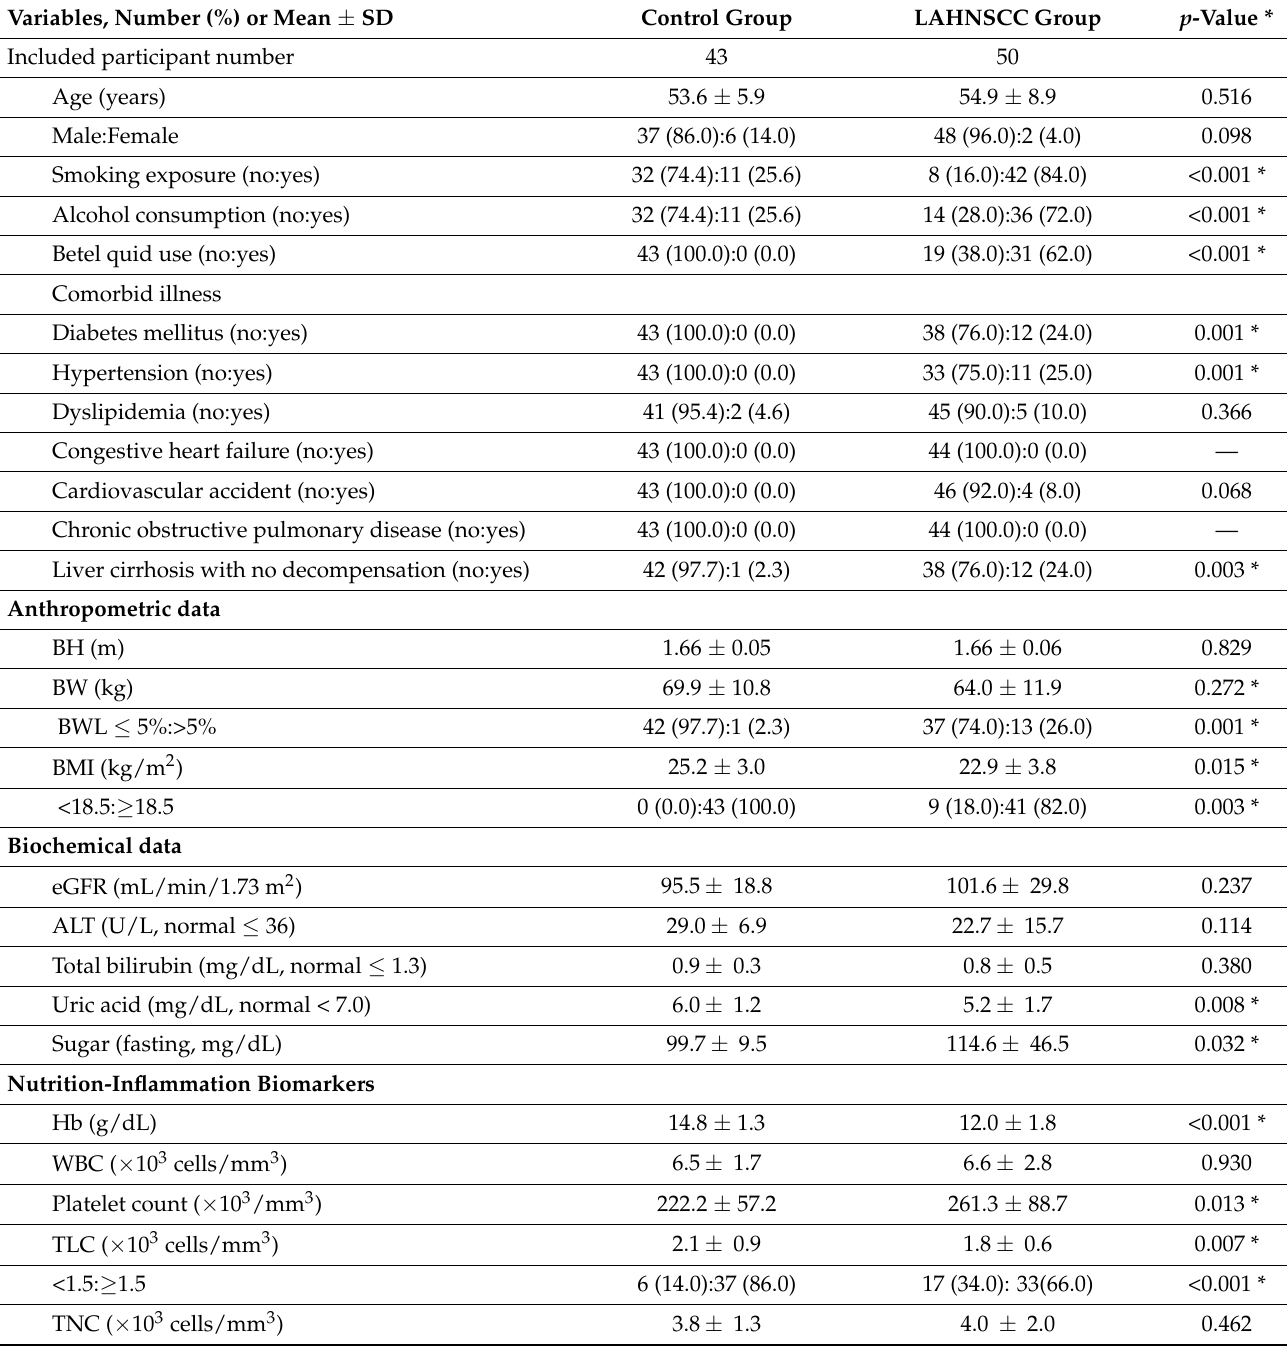
Table 1. Clinical features, anthropometric data, biochemical data, nutrition-inflammation biomarkers measurements, and serum metabolites concentrations in the healthy control and patients with LAHNSCC